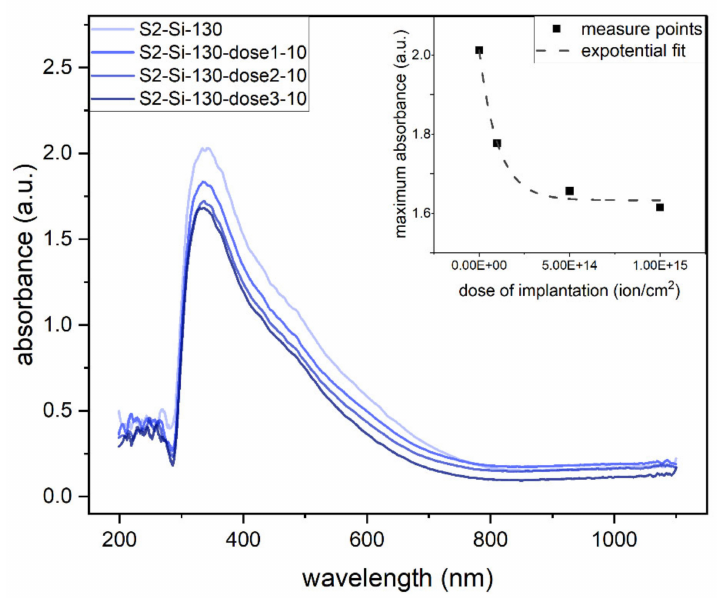
Figure 9. Absorbance of second series samples: CuO 130 nm on glass with different implantation at 10 keV. Inset: maximum absorbance as function of implantation dose.